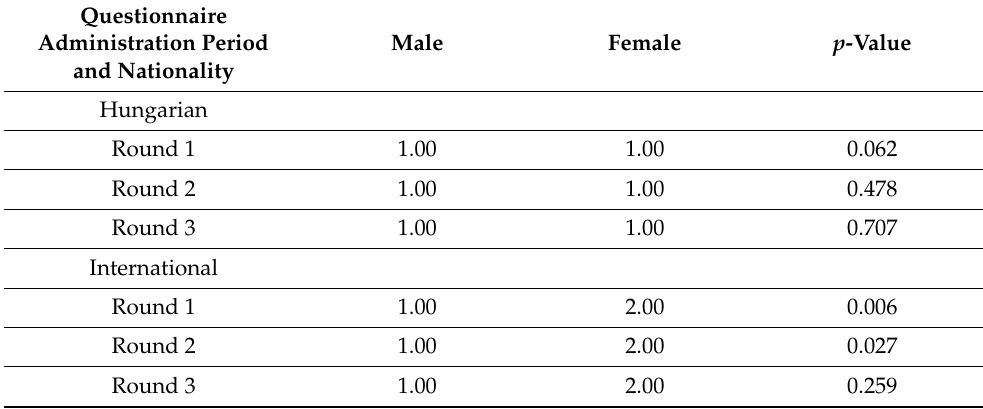
Table 6. Differences in depression levels between domestic and international students.